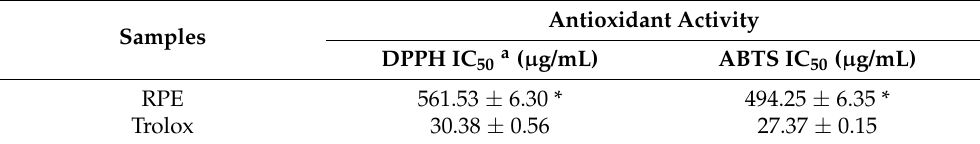
Table 4. Antioxidant activity of rambutan peel extract (RPE).